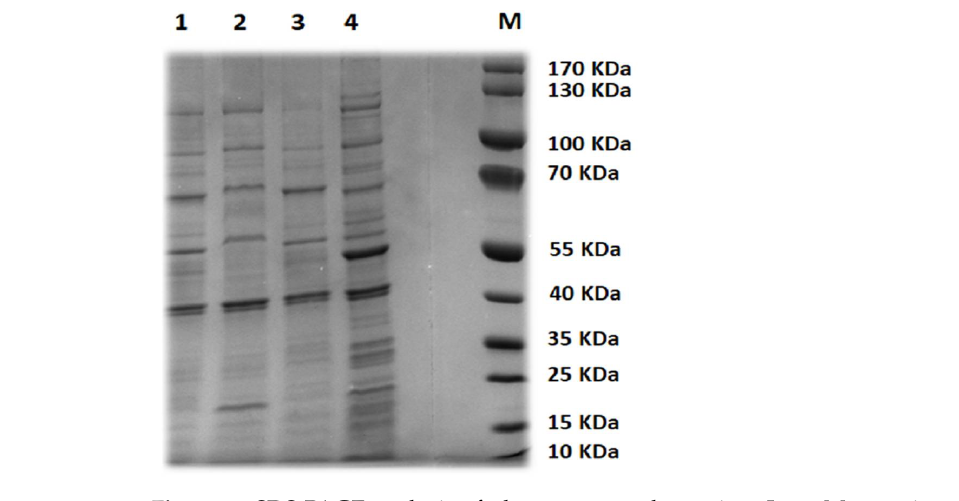
Table 1. Host range of selected STEC